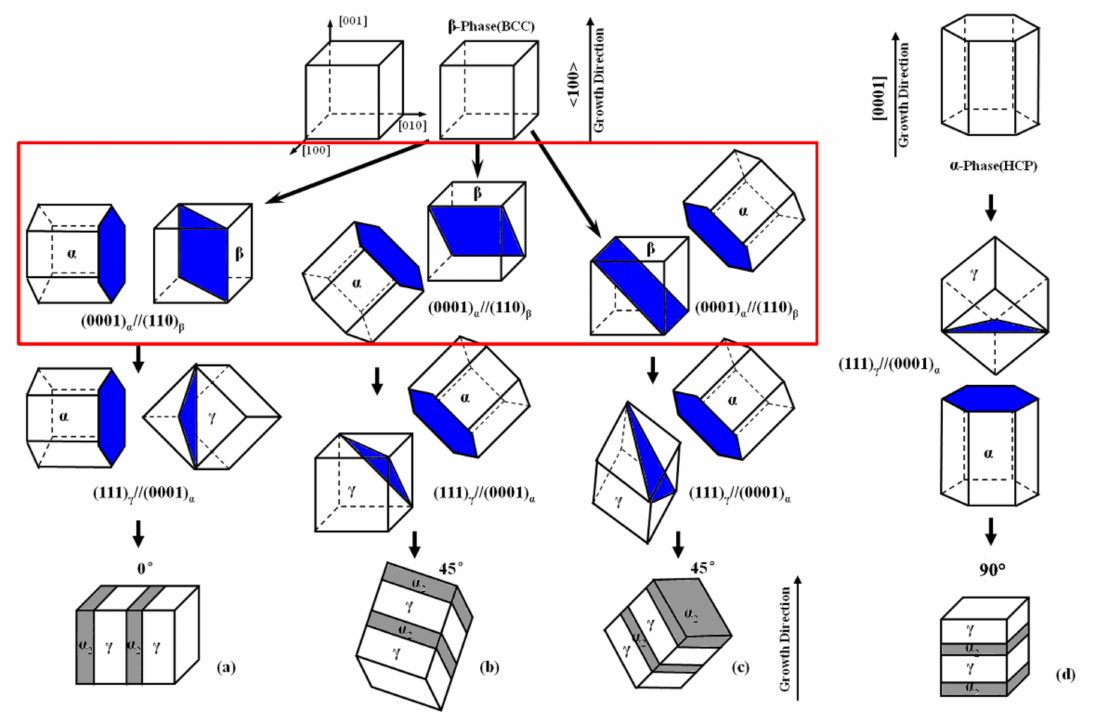
Figure 1. Relationships between lamellar orientations and crystal orientations of TiAl-based alloys during DPT. ( a – c ) 0 ◦ and 45 ◦ oriented lamellae acquired through β → α and α → α 2 + γ phase transformation for β -solidifying TiAl alloys, ( d ) 90 ◦ oriented lamellae acquired through α → α 2 + γ phase transformation for α -solidifying TiAl alloys